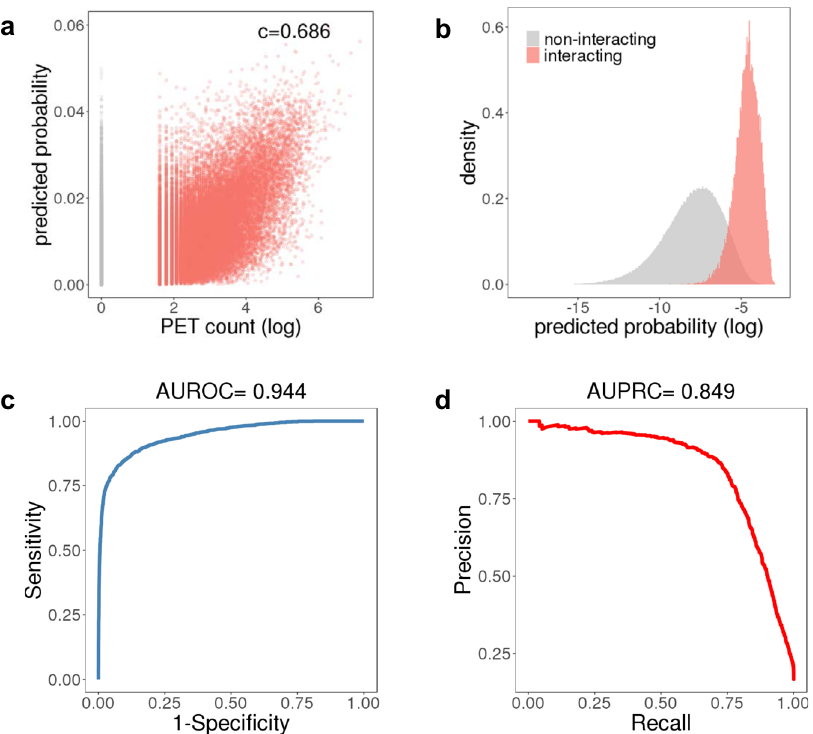
Fig. 4 Model validation by quantitively assessing CTCF ChIA-PET and Micro-C dataset. a Distribution of PET count (log scale) against loop extrusion model predicted interaction probability. Red dots are interacting CTCF pairs while grey dots are non-interacting CTCF pairs. b Distribution of loop extrusion model predicted interaction probability. c , d Validation of model prediction performance on Micro-C CTCF loops with AUROC and